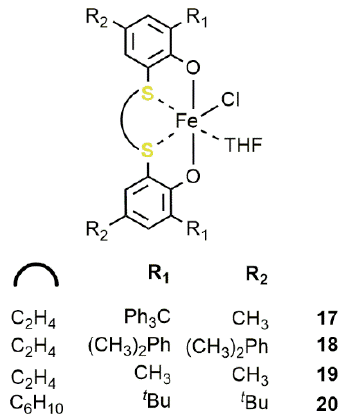
Figure 15. Iron(III)-[OSSO] complexes 17-20 [52].